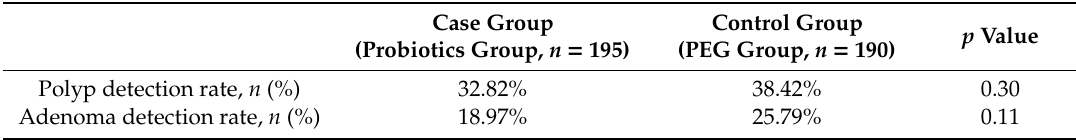
Table 3. Comparisons of the e ffi cacies in the polyp detection rate according to the bowel segments between